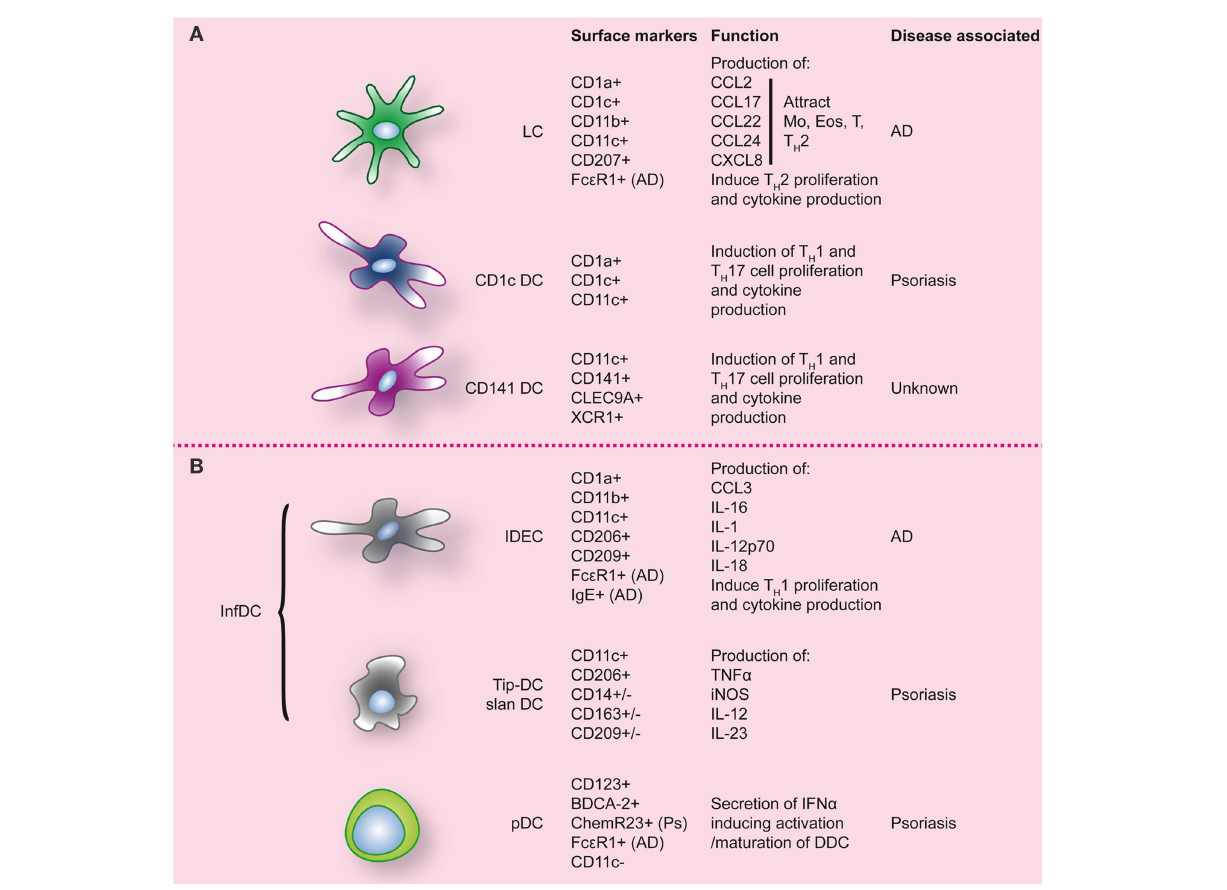
FIGURE 3 | Dendritic cell populations in human skin during inflammatory conditions . Inflamed skin contains not only DC that were already present at steady-state (A) , but also DC that migrated into the skin (B) . Markers